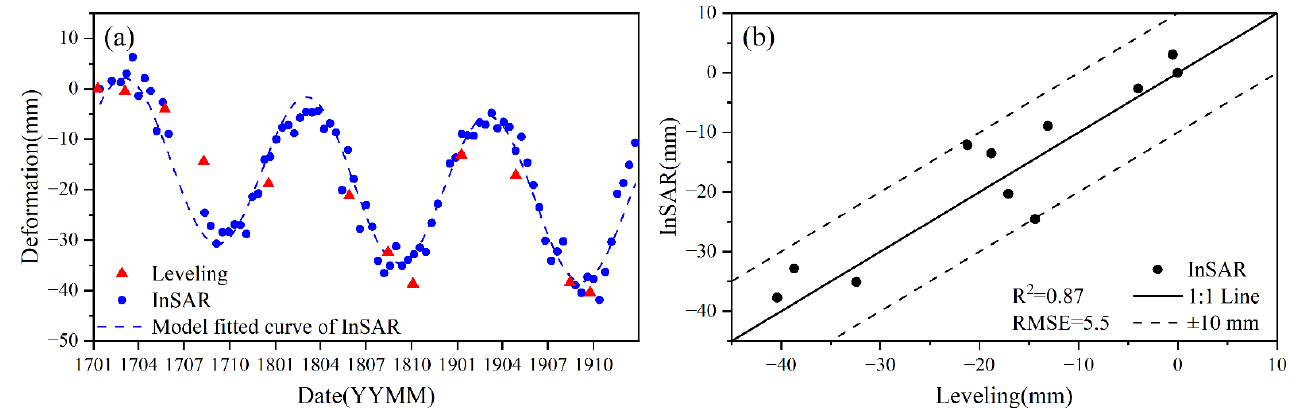
Figure 4. Comparision ( a ) and cross-validation ( b ) between SBAS-InSAR observation and meas- ured data.